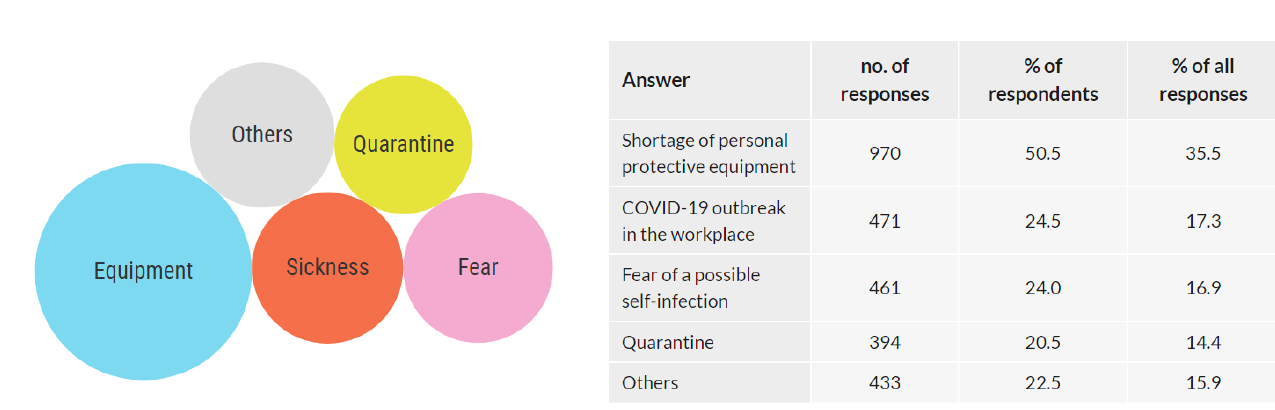
Figure 5. Time range of Czech dental practices closure during the whole pandemic.